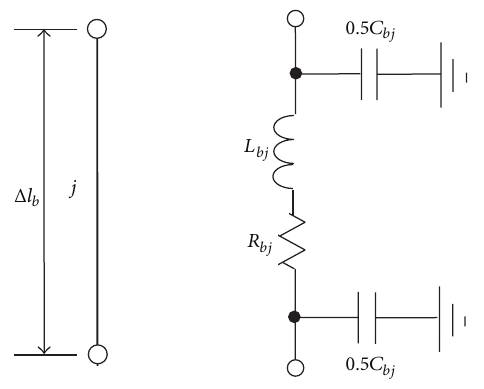
Figure 2: 𝜋 -type circuit of a down conductor segment. −1 𝜉 − √1 + 𝜉 2 where 𝜑(𝜉) = 𝜉 sinh . According to the electro- magnetic analogy [8–10], the capacitance 𝐶 𝑏𝑗 is determined